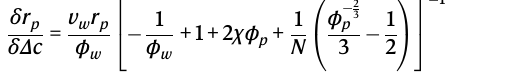
Fig. 3 | Regulation of CNTs-PA membrane pore size via applied voltage. a Schematicillustrationofnano fi ltrationusingCNTs-PAmembraneasthecathode. b PEG rejections as function of molecular weight by the CNTs-PA membrane and corresponding MWCO at different applied voltages in the presence of 1000 ppm Na 2 SO 4 . c PoreradiusofCNTs-PAmembraneasafunctionofappliedvoltageinthe presence of 1000 ppm Na 2 SO 4 . d Pore radius of CNTs-PA membrane as a function ofNa 2 SO 4 concentrationatanappliedvoltageof1.0V. e Reversiblechangeofpore